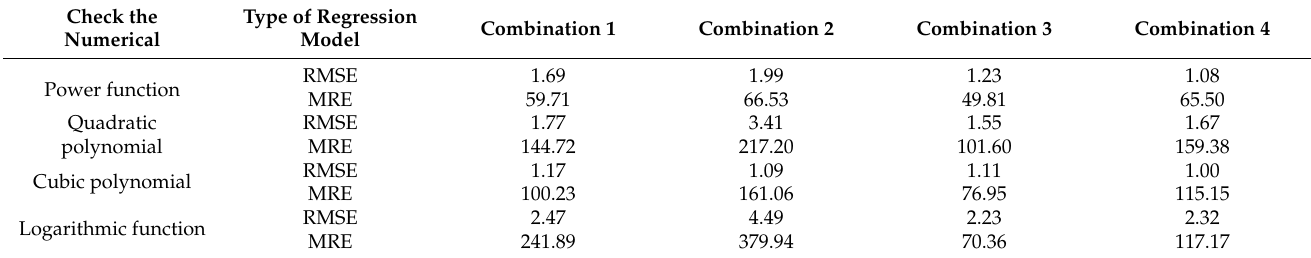
Table 3. Statistical table of error terms in inversion results of each regression